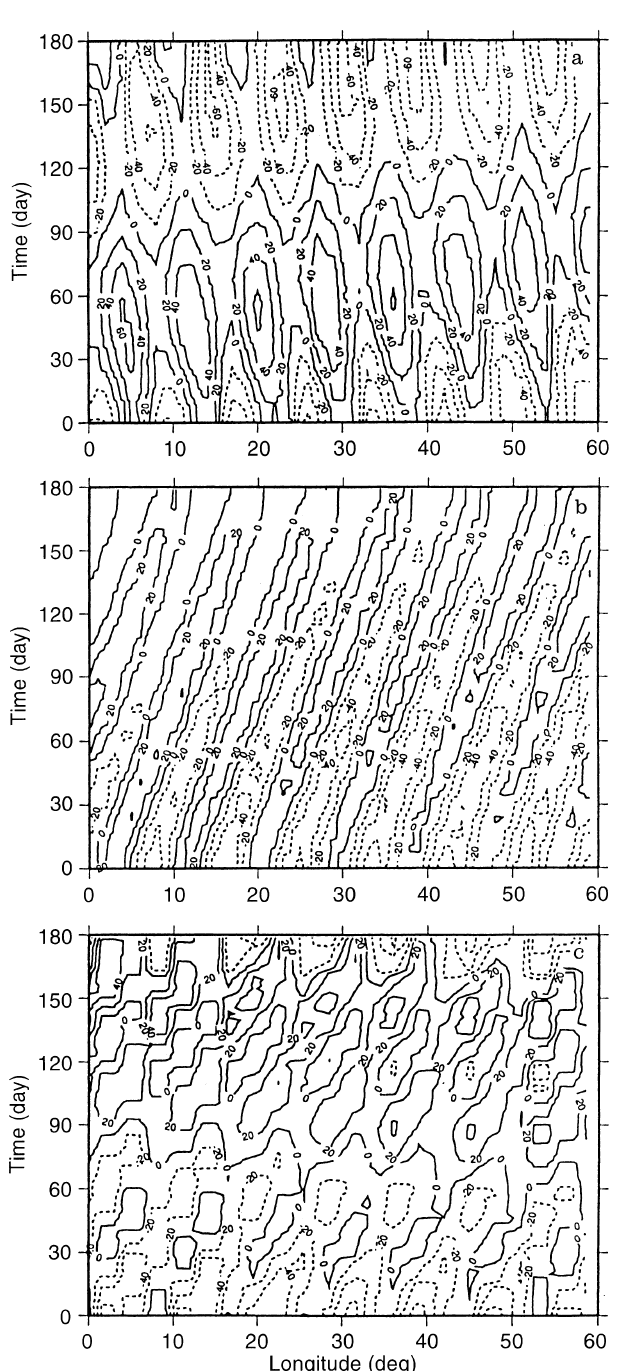
Fig. 8a–c. Time/longitude diagrams of simulated propagation of the combined six major tidal constituents under the sampling scheme of a Geosat, b ERS and c TOPEX/POSEIDON. The contours have been multiplied by 100 and the interval is 20. Solid and dashed lines denote positive and negative e(cid:128)orts to extract the real phase speed of such signals through alias wave propagation on the basis of altimetric time/longitude diagrams are unattainable.